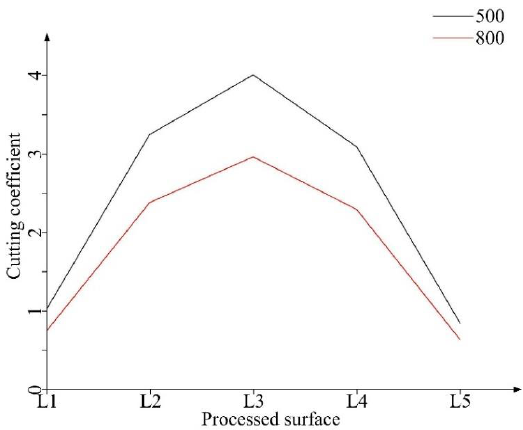
Figure 28. The cutting coefficient K 0 of different position.